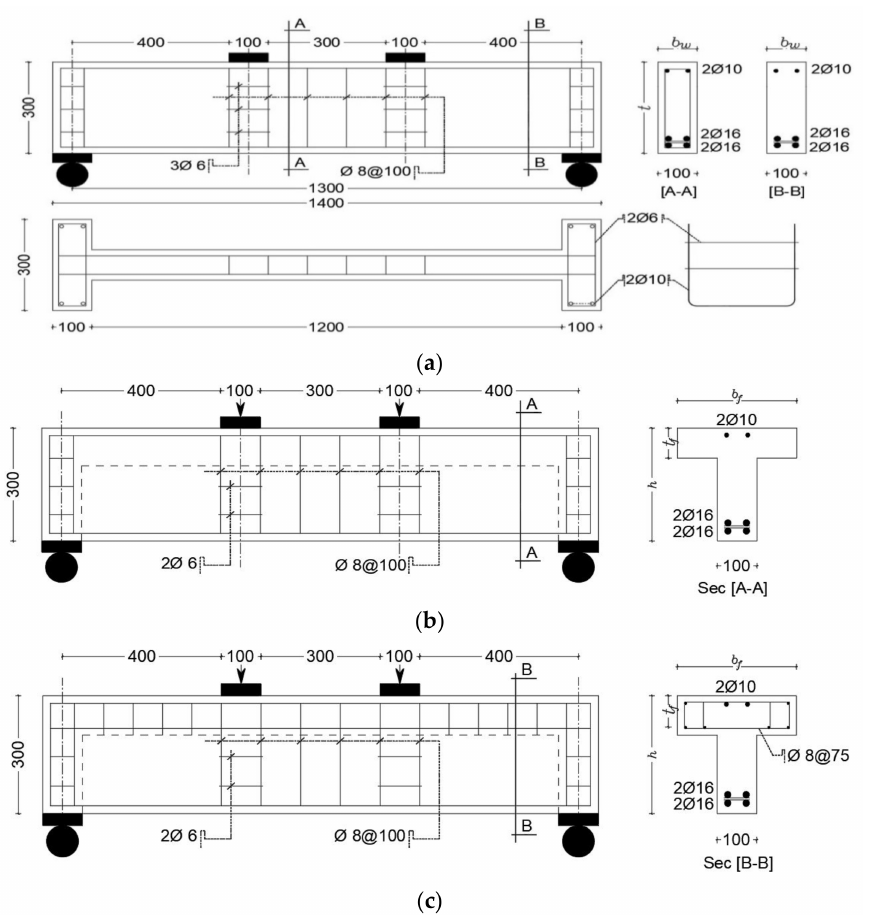
Figure 1. Specimen details and arrangement of reinforcement (all dimensions are in mm). ( a ) Specimen with rectangular cross-section (control); ( b ) specimen with T-cross-section without stirrups in flange; ( c ) specimen with T-cross-section with stirrups within flange. The specimens are loaded until the failure occurs with two-point loads that gives a shear span-to-depth ratio equal to 1.5. A 1000 kN capacity hydraulic jack is used in loading. All specimens are designed to motivate shear failure before flexural failure occurs. Figure 1 presents the typical details of the tested specimens. The main bottom reinforcement is about four steel bars in all specimens Ø16 (diameter of 16 mm and area of 201 mm 2 ), which are laid in two layers at the bottom of the beam cross-section and two Ø10 bars (diameter of 10 mm and area of 78.54 mm 2 ) laid in one layer at the top. To avoid causing early anchorage failure, the bottom and top bars are anchored at the support with 90-degree hooks. The web reinforcement has a Ø8@100 mm spacing in the middle part between two applied loads.